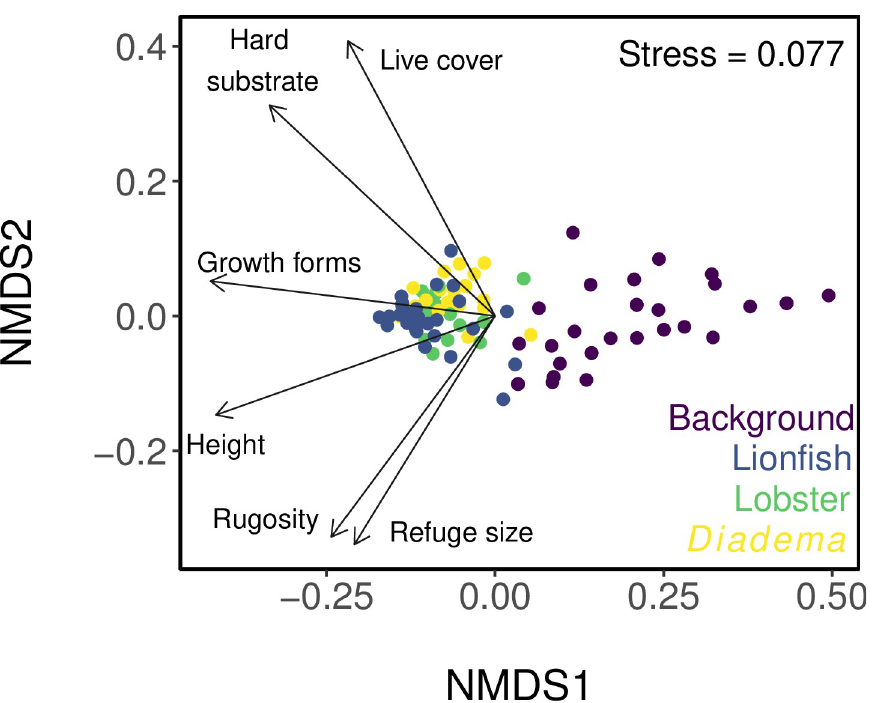
Fig 3. Non-metric multidimensional scaling ordination of reef quadrat complexity. Each point represents a 1 x 1 m quadrat that is either a randomly sampled background quadrat ( n = 36), or contains a lionfish ( n = 35), lobster ( n = 28) or Diadema ( n = 22). The plot was constructed using values of the six HAS categories: rugosity, variety of growth forms, substratum height, maximum refuge size, percentage live cover and percentage hard substratum. Quadrats with more similar complexity are closer together on the plot. Vectors indicate the direction of the gradient for each HAS category.